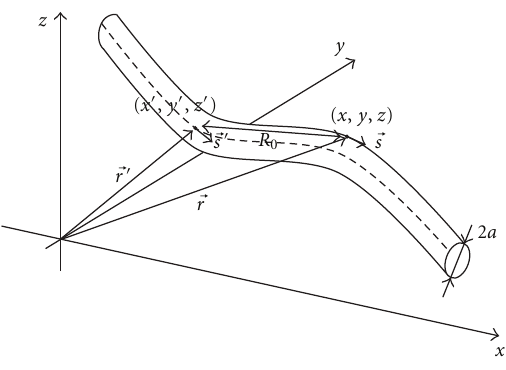
Figure 1: Single wire of arbitrary shape in free